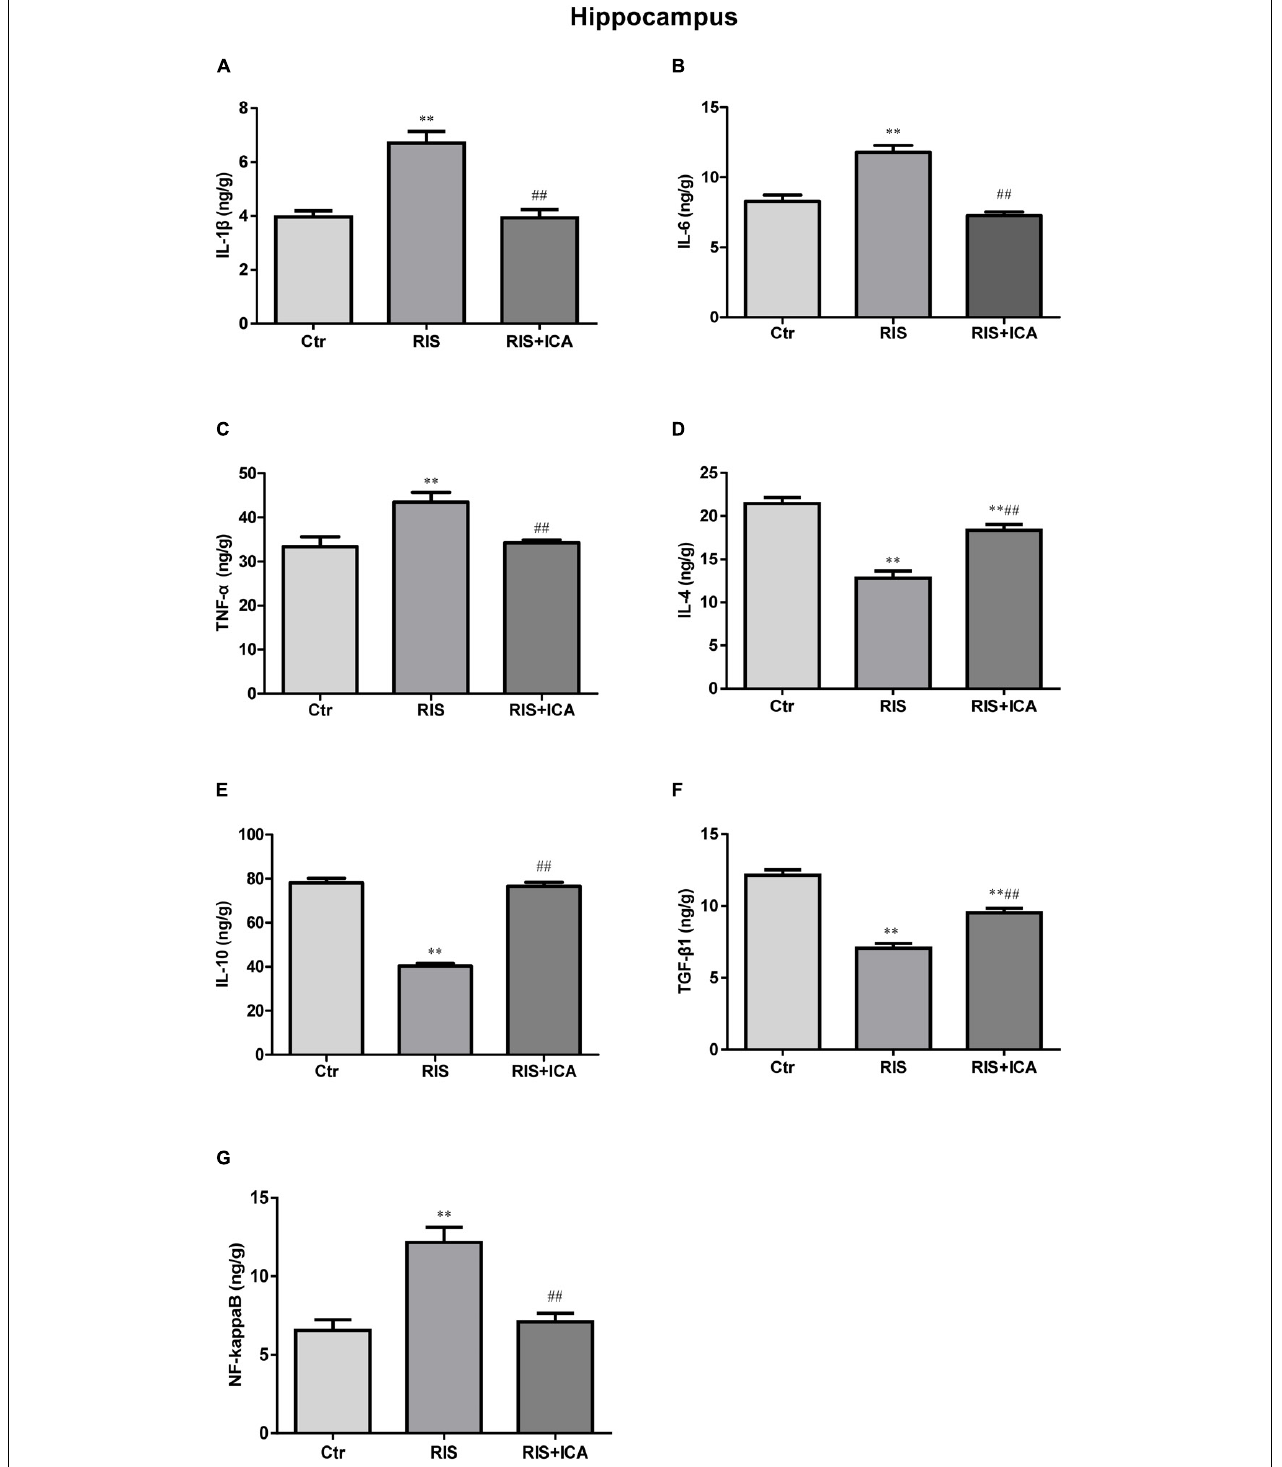
FIGURE 4 | Effect of icariin on cytokines and NF- κ B in the hippocampus. (A–C) The level of IL-1 β (A) , IL-6 (B) , and TNF- α (C) increased in the RIS group, and icariin relieved the alteration. (D–F) The level of IL-4 (D) , IL-10 (E) , and TGF- β 1 (F) decreased in the RIS group, and icariin relieved the alteration. (G) The level of NF- κ B increased in the RIS group, and icariin relieved the alteration. The results are expressed as the mean ± SEM, n = 6. ∗∗ p < 0.01 vs. control group; ## p < 0.01 vs. RIS group.